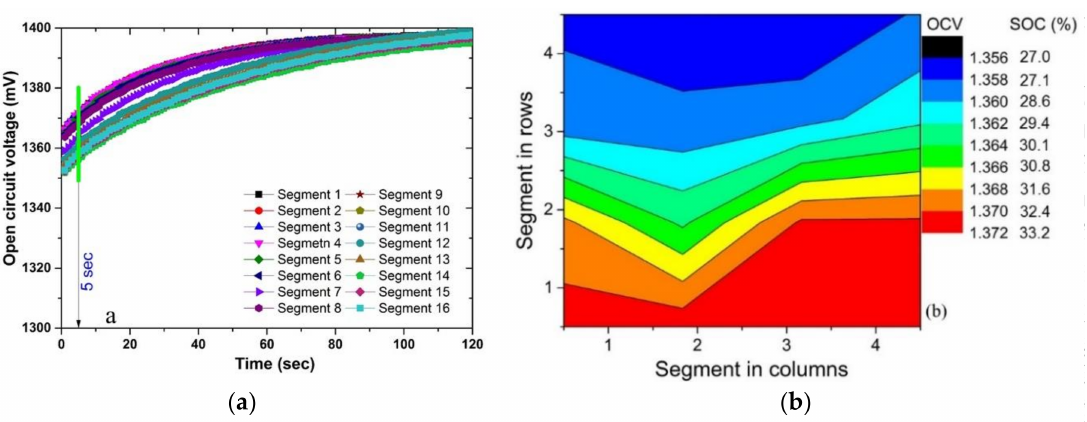
Figure 2. ( a ) OCV vs. time curve after terminating the discharge at 80 mA cm − 2 and ( b ) the corresponding contour diagram at 5 s in OCV after termination. The flow rate was 42 mL min − 1